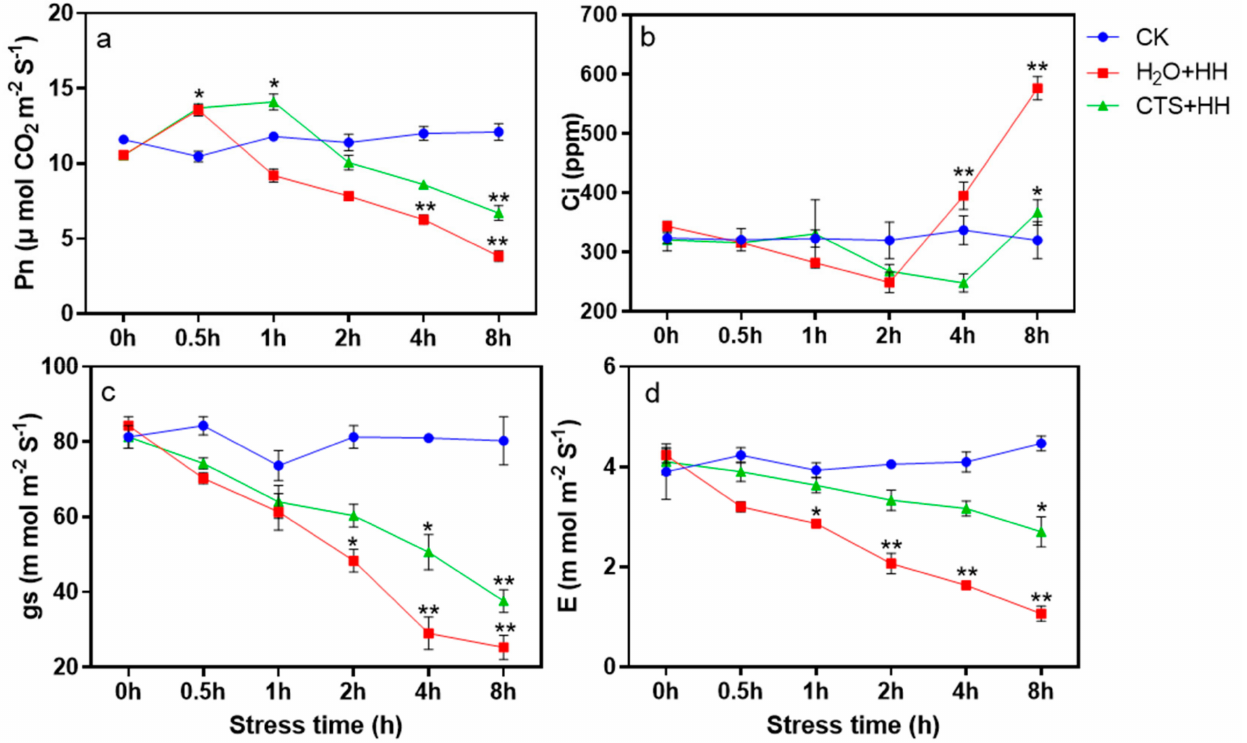
Figure 2. Effect of CTS on leaf gas exchange parameters of strawberry seedlings under high- temperature and high-light stress.( a ) net CO 2 exchange, P n ; ( b ) intercellular carbon dioxide concentra- tion, C i ; ( c ) stomatal conductance, g s ; ( d ) transpiration rate, E. CK: H 2 O + 23 ◦ C + 400 µ mol · m − 2 · s − 1 ; H 2 O + HH: H 2 O + 38 ◦ C + 1800 µ mol · m − 2 · s − 1 ; CTS + HH: CTS + 38 ◦ C + 1800 µ mol · m − 2 · s − 1 . * indicates that there is a significant difference between treatments (Duncan’s multiple range test; p < 0.05); and **, a very significant difference (Duncan’s multiple range test; p <